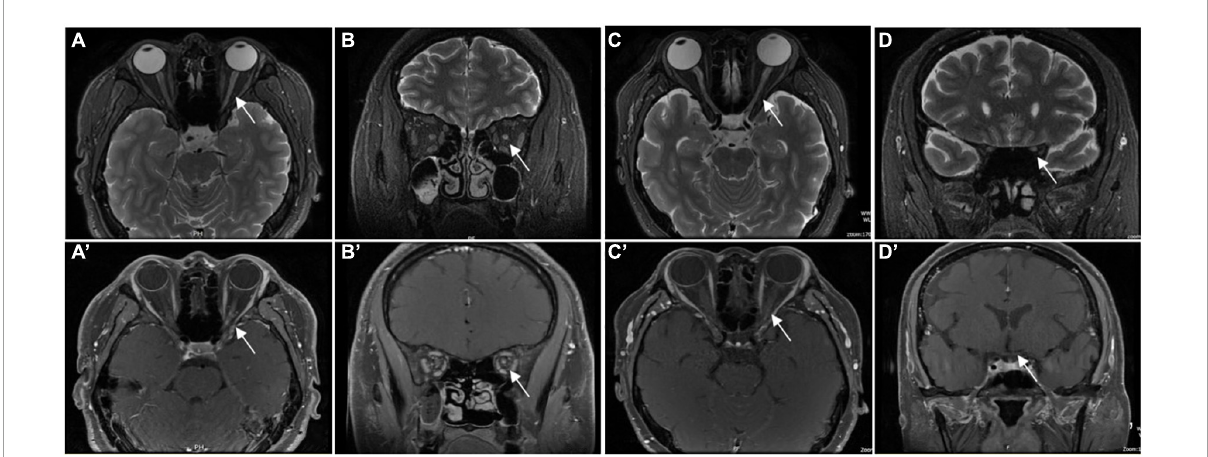
FIGURE2 Orbital MRI images in patients who were diagnosed with ON. Panels (A,C) (axial) and (B,D) (coronal) showed the high signal of the left ON (the white arrow) in T2WI. Panels (C) (axial) and (D) (coronal) showed the enhancement of left ON (the white arrow) in gadolinium-enhanced T1. Panels (A (cid:48) ) (axial) and (B (cid:48) ) (coronal) showed the enhancement of left ON (white arrow) in gadolinium enhanced T1. Panels (C (cid:48) ) (axial) and (D (cid:48) ) (coronal) showed the normal signal of left ON (the white arrow) in gadolinium-enhanced T1.